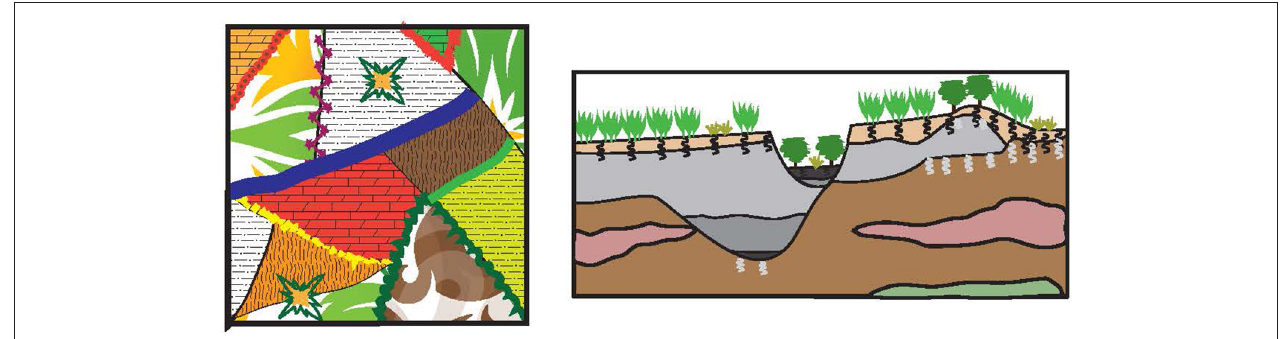
FIGURE 8 | An illustration of the patchwork CZ conceptual model. The left panel is an example of a crazy quilt design. Irregularly shaped pieces of a range of different fabrics are stitched together and embellished with embroidery. This is similar to the CZ shown on the right in which a range of diverse materials are juxtaposed and weathering reactions alter some of their